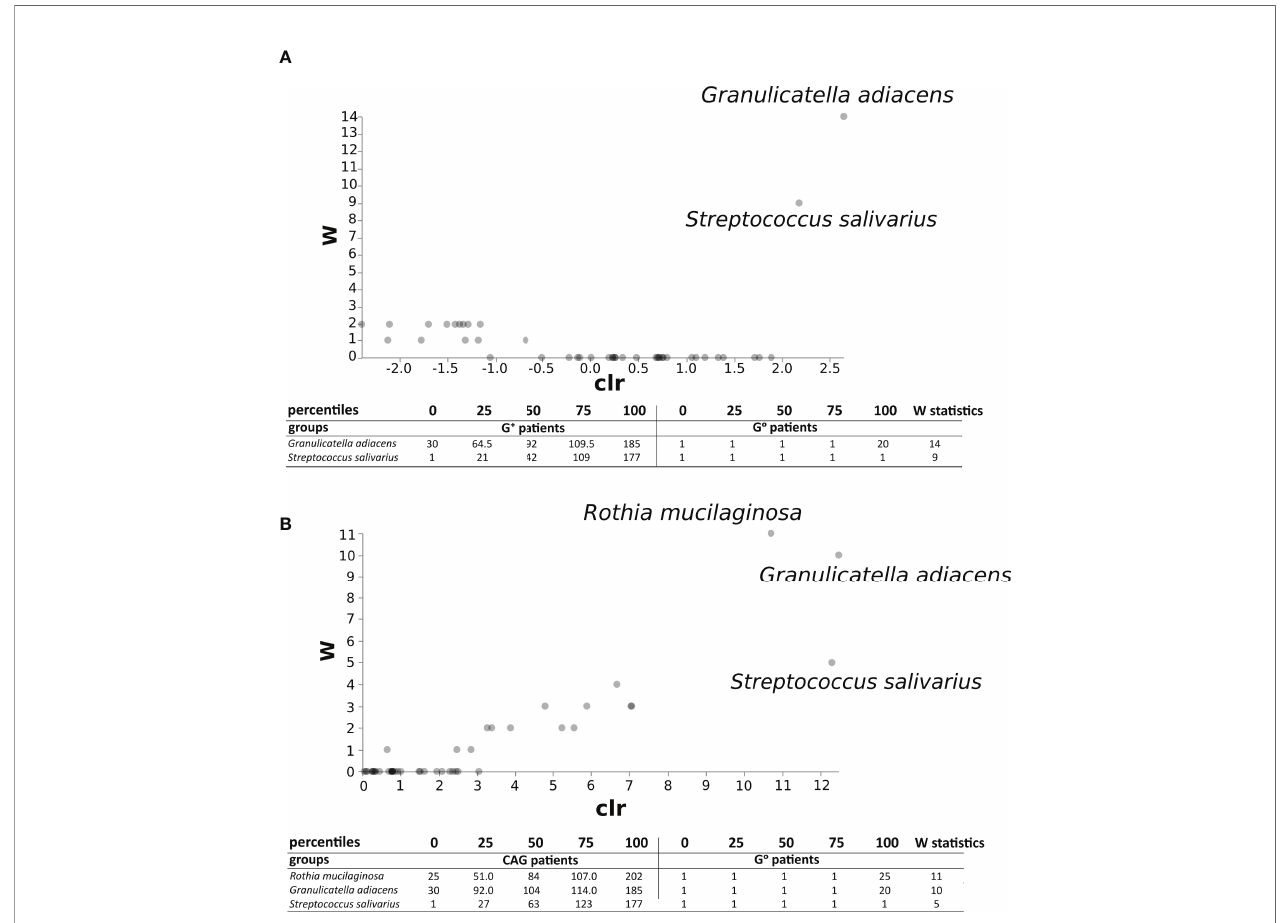
FIGURE 7 | ANCOM test in the duodenal microbiota between CAG or G+ patients, and G 0 patients. ANCOM analysis in CAG (A) and G + patients (B) . W statistics represent the number of times the null hypothesis is rejected for a given